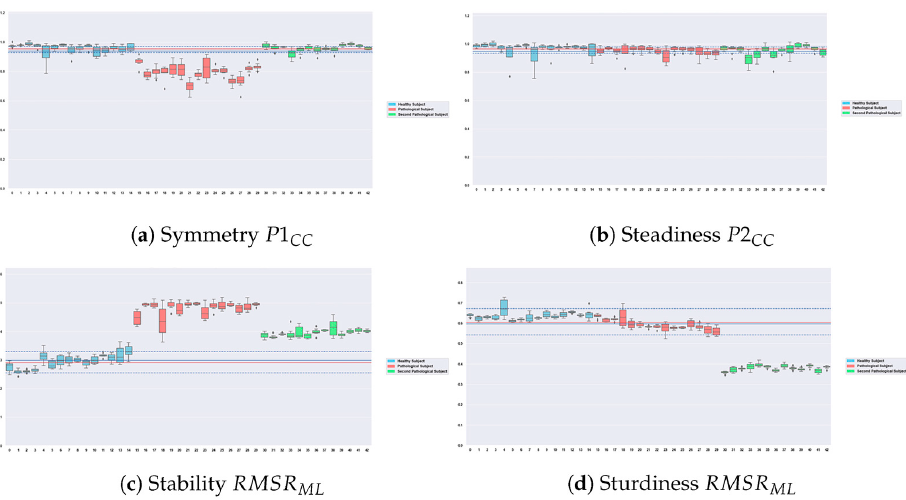
Figure 7. Evaluation of the robustness of selected features. Features with low dispersion and high discrimination between classes. The blue horizontal line shows the average value of the feature for all healthy subjects, the red horizontal line shows the median value of the feature for all healthy subjects, and the dotted lines correspond to the 75th/25th percentiles. Each boxplot corresponds to 10 computations of the feature on a walking regime on 10 degraded ranges. Boxplots are displayed with specific colors depending on their associated subject: blue for a healthy subject, red for PSU1 , and green for PSU2 .